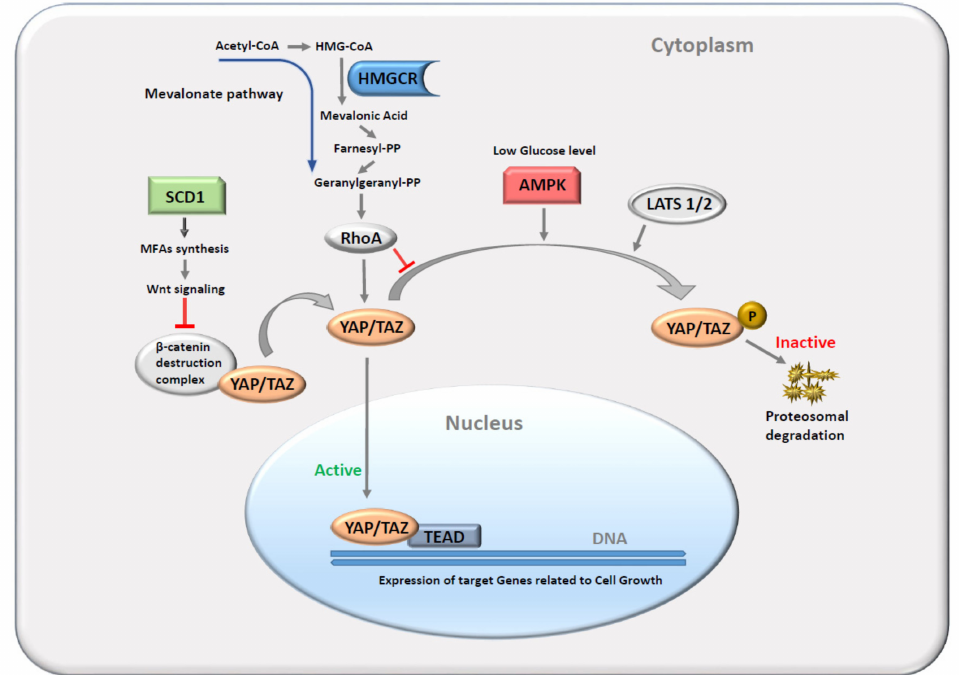
Figure 1. A simplified scheme of the main Hippo pathway kinases and effectors and the modulating effects from main cellular metabolism regulators. Only core components of interest in our study are shown in colored shapes. The effectors YAP and TAZ are inactivated after LATS1/2-facilitated phosphorylation or, alternatively, enter the nucleus and bind to TEAD transcription factors activating the expression of genes related to cell growth. Low levels of glucose, acetyl-CoA, and MFAs favor YAP/TAZ inactivation through the AMPK, HMGCR-RhoA, and SCD1-Wnt- β -catenin pathways, respectively. Abbreviations: YAP, Yes-associated protein; TAZ, transcriptional coactivator with PDZ- binding motif; AMPK, AMP-activated protein kinase; HMGCR, HMG-CoA reductase; RhoA, Ras Homolog Family Member A; SCD1, Stearoyl-CoA-desaturase 1; MFAs, monounsaturated fatty